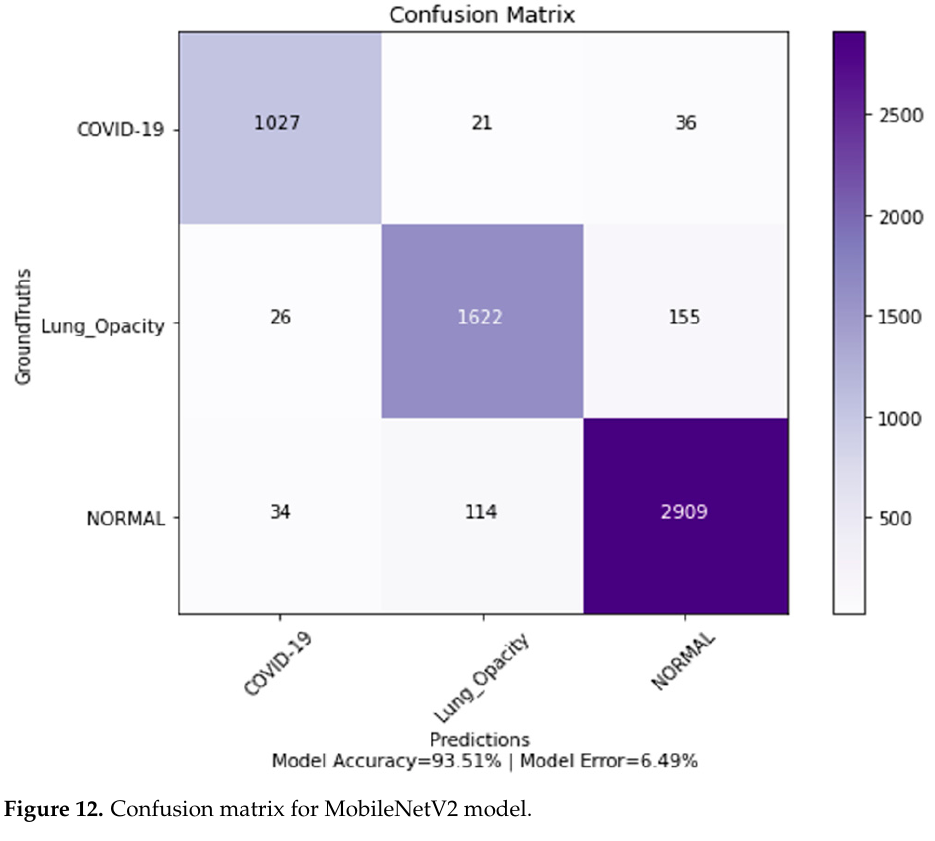
Figure 11. Confusion matrix for Custom-Model.